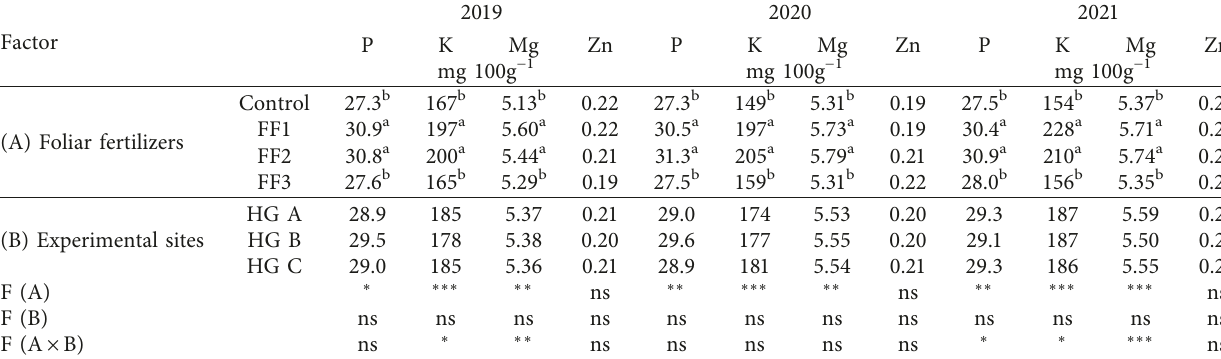
Table 3: Concentrations of P, K, Mg, and Zn in whole fruits (dry weight).